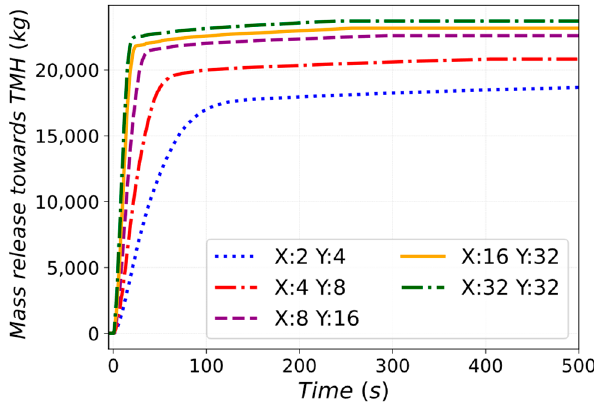
Figure 23. Mass discharge toward the TMH area.